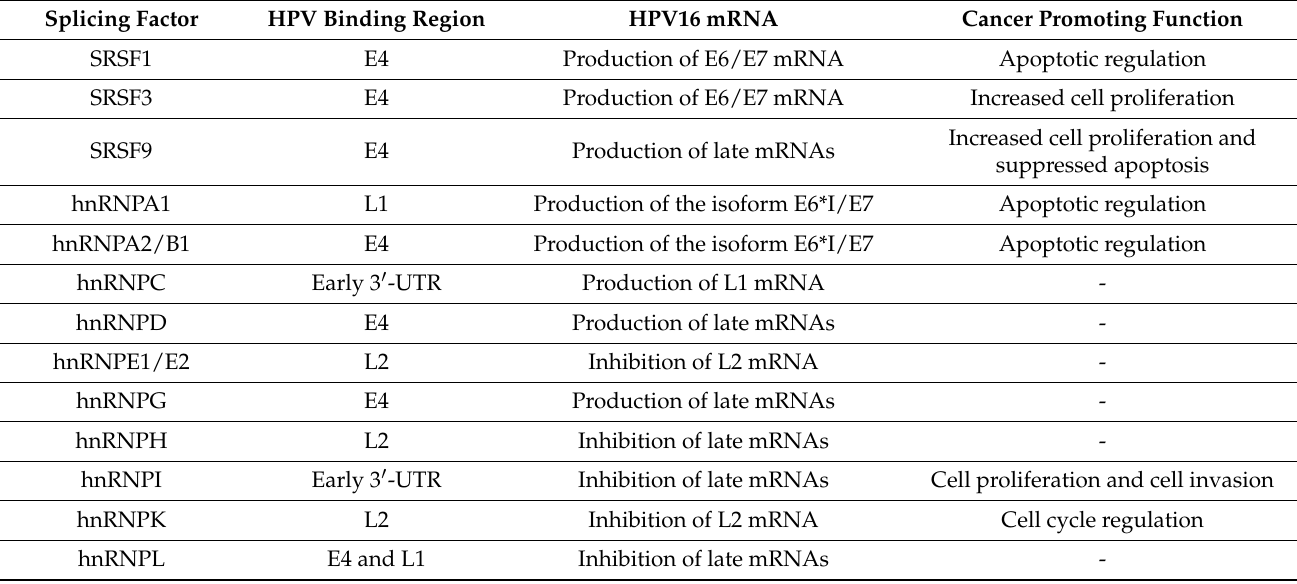
Table 2. The role of major splicing factors, the human papillomavirus (HPV) binding region, and function of transcripts in cancer